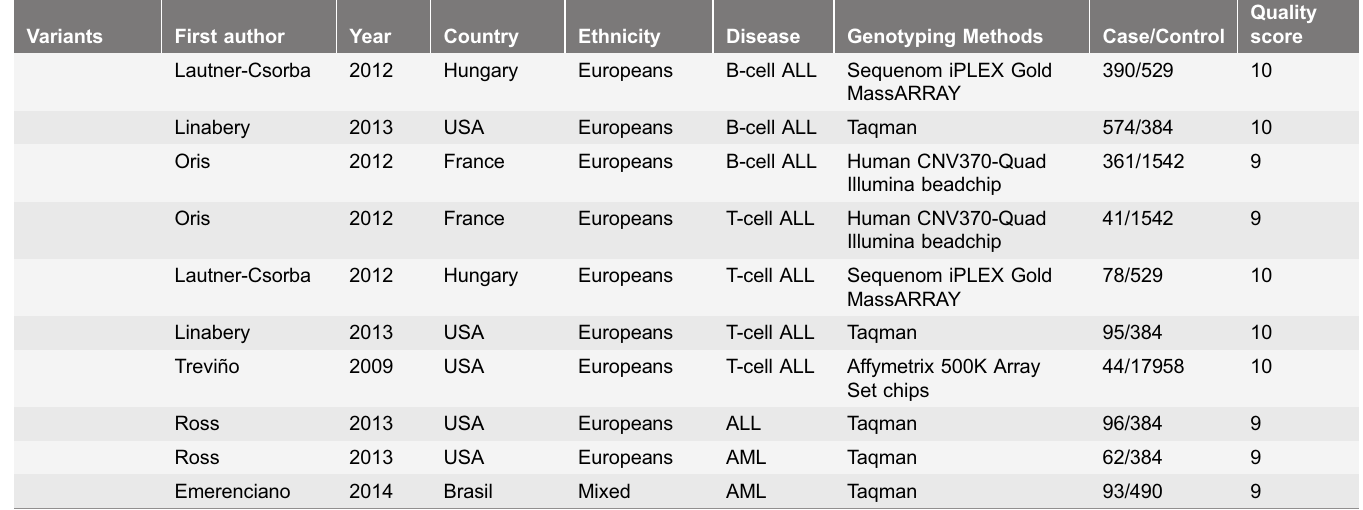
Test of heterogeneity Heterogeneity was significant in most comparisons of the two IKZF1 SNPs. The